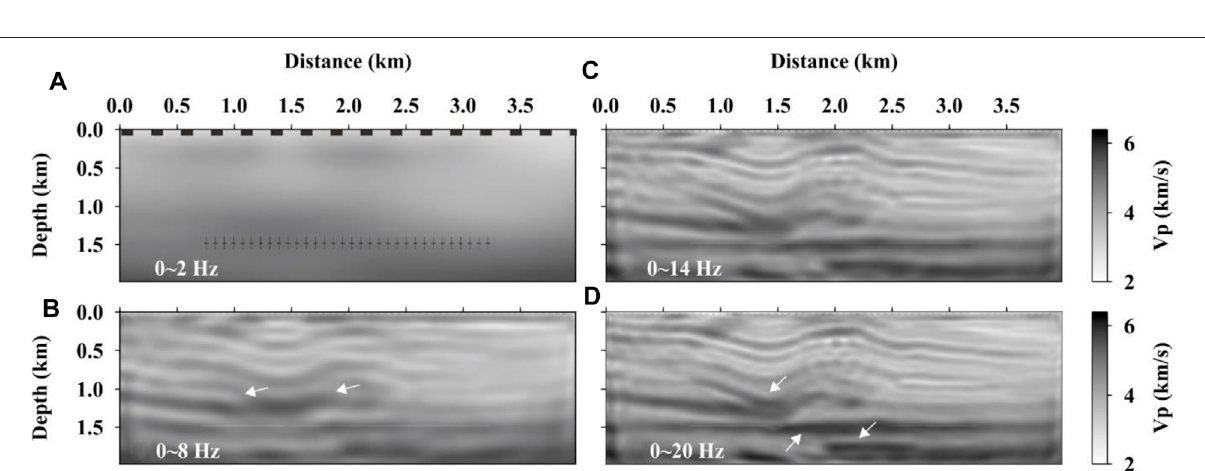
Frontiers in Earth Science |